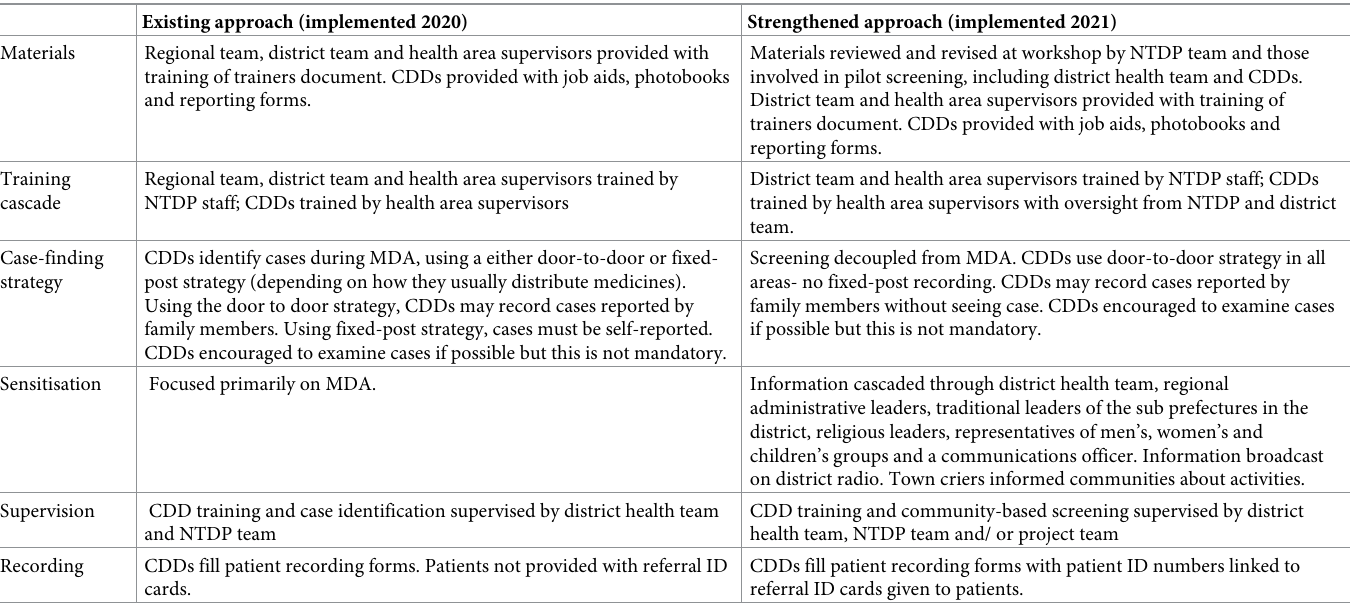
Table 1. Existing and strengthened approach to community-based screening for lymphatic filariasis morbidity (LFM) in Coˆte